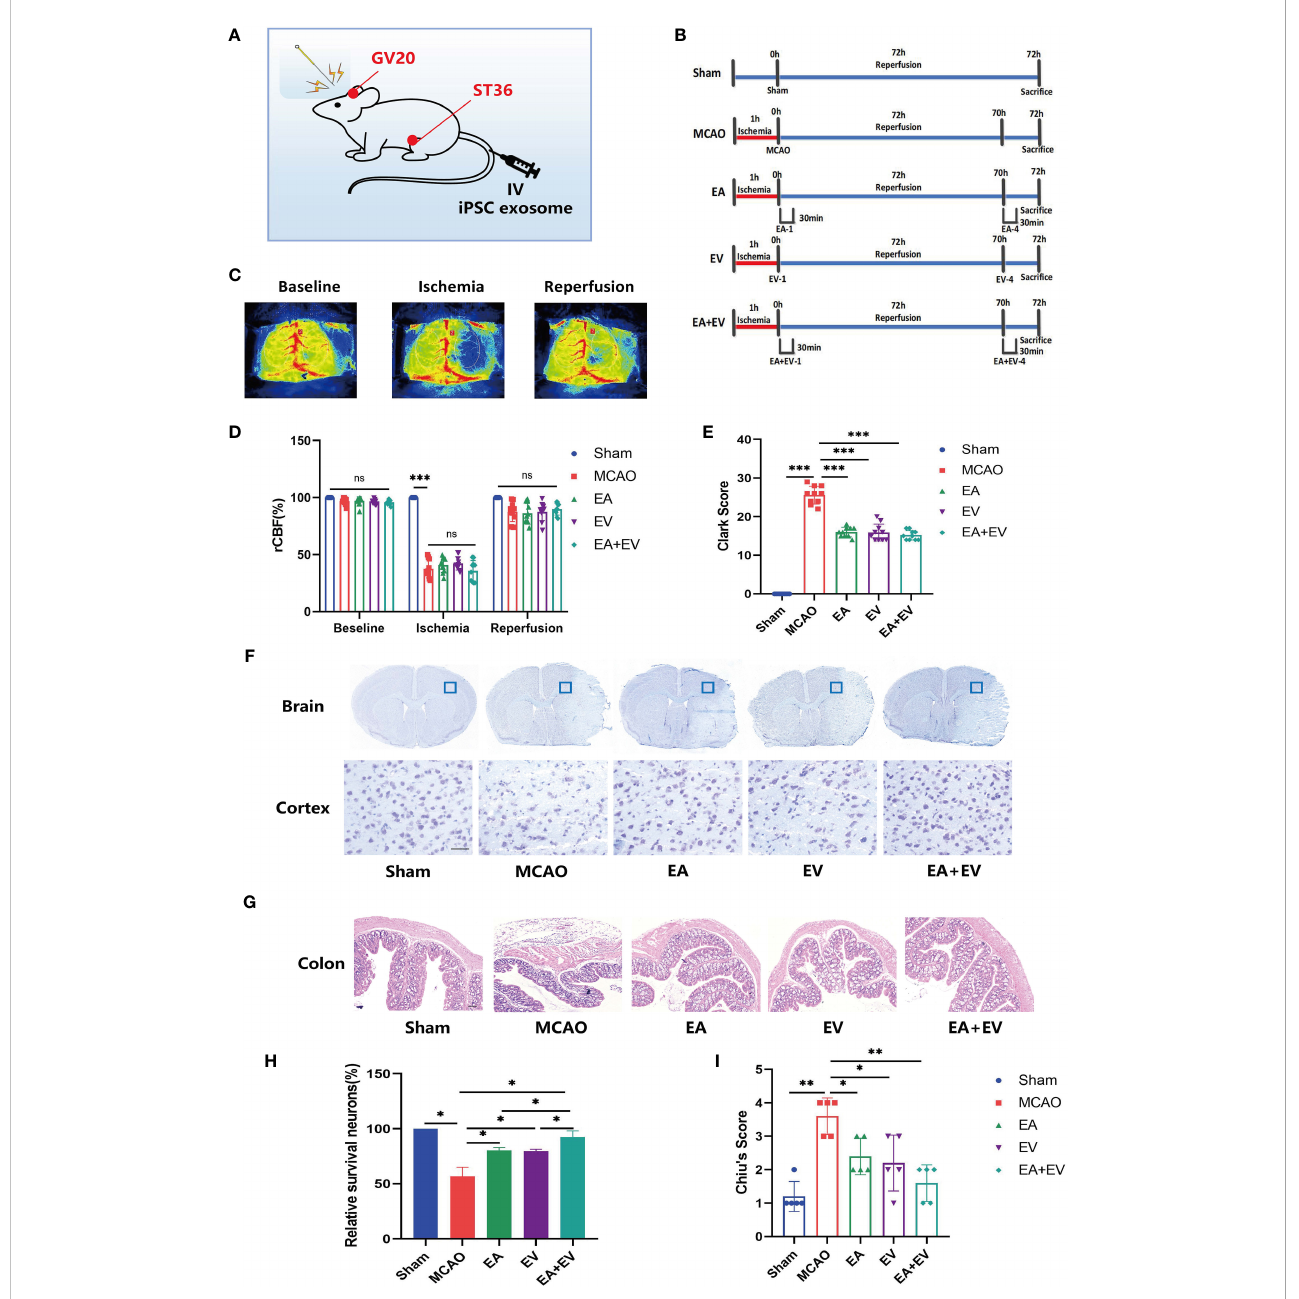
FIGURE 1 EA and iPSC-EVs treatments reduce brain tissue and intestinal injury after cerebral ischemia − reperfusion. (A) Image of mouse EA and iPSC-EVs treatments. (B) Diagram of the experimental paradigm used in each group. (C, D) Cerebral blood fl ow was monitored by rCBF laser speckle before and after MCAO and after reperfusion. Scale *** indicates signi fi cant differences between the Sham and MCAO groups, ns indicates no differences in MCAO, EA, EV, and EA+EV between groups after ischemia, n=10/group. (E) The Clark score was used to evaluate the degree of neurological impairment. (F) Representative images of Nissl staining. Scale bar=50 m m. (G) Injury of the colon after cerebral injury. Scale bar=100 m m. (H) Quanti fi cation of the number of neurons positive for Nissl staining, n=4/group. (I) Chiu ’ s score of colon injury after cerebral ischemia. Data were expressed as the mean±SD, * P <0.05, ** P <0.01, *** P